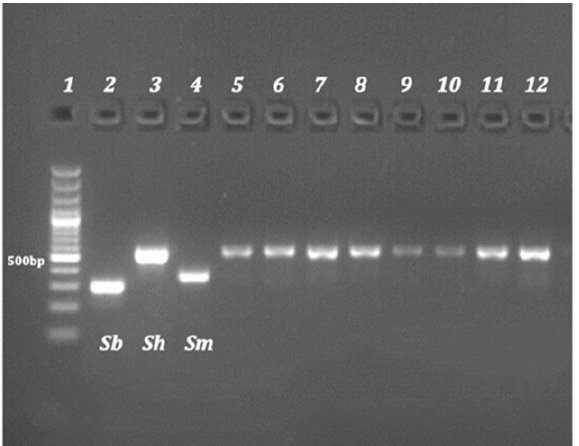
Figure 4. Mitochondrial cox -1 profile by RD-PCR. Lane 1: DNA ladder (100–3000 bp); lane 2: S. bovis (306 bp); lane 3: S. haematobium (543 bp); and lane 4: S. mansoni (375 bp). Each of the following lanes (5–12) corresponds to a separate multiplex PCR containing DNA extracted from one single egg, where lanes 5–8 match with the eggs of a patient from Mali, 9–10 from Senegal and 11–12 from